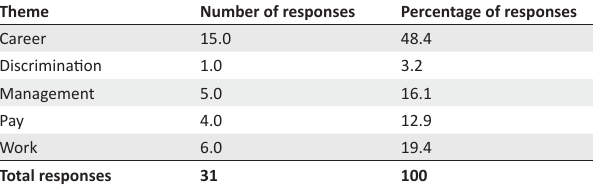
TABLE 15: Silent soldier cluster of